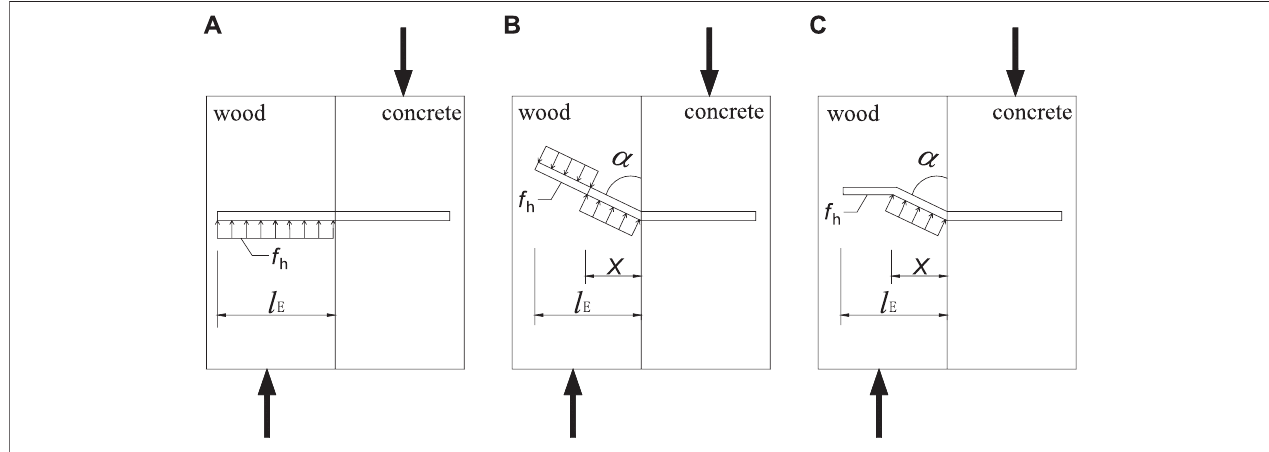
TABLE 5 | Comparison of shear capacity (units: kN). Specimens Ceccottimodel Test B3008